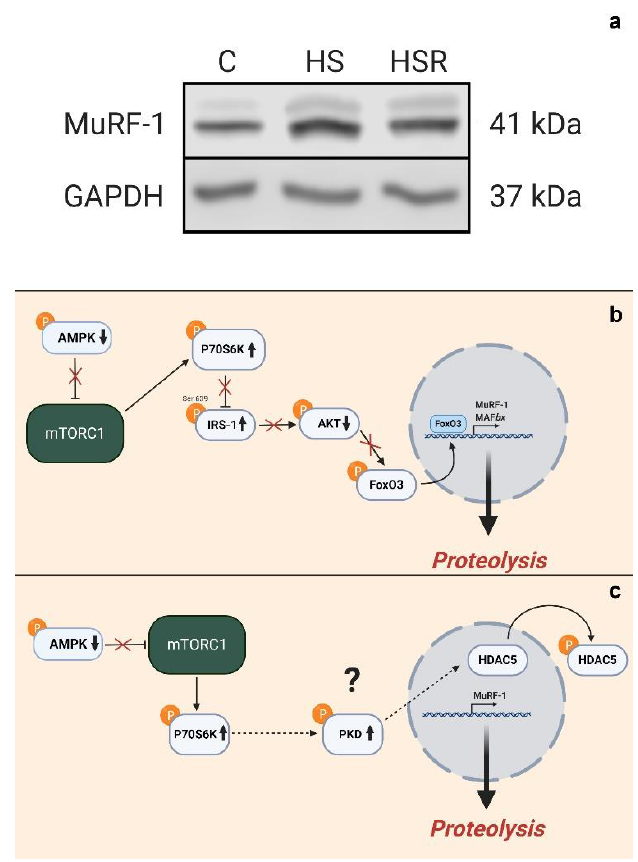
Figure 3. Causes and signaling consequences of the increased phosphorylation of ribosomal protein S6 kinase (p70S6K) during the first day of unloading (according to Belova et al. [13]). ( a ) Experimental confirmation of the role of increased p70S6K (Thr389) phosphorylation in the early increase in the expression of E3-ubiquitin ligases. During the first day of unloading, there is an increase in protein expression levels of MuRF-1. When rapamycin (mTORC1 inhibitor) reduces the level of p70S6K phosphorylation, the increase in MuRF-1 expression is not detected. ( b ) An initial hypothesis suggesting the role of increased p70S6K phosphorylation in the regulation of MuRF-1 expression via IRS-1 downregulation (Hsieh et al. [55]). AMPK dephosphorylation leads to the mTORC1 unblocking and increased p70S6K phosphorylation, which, in turn, phosphorylates IRS-1 at Ser639 thereby inhibiting downstream components of IGF-1- signaling. These events can lead to FOXO3 nuclear and increased MuRF-1expression. However, it turned out that the blocking of this signaling cascade does not depend on p70S6K phosphorylation. ( c ) A working hypothesis suggesting the role of increased p70S6K phosphorylation in stimulating MuRF-1 expression through the removal of the histone deacetylase 5 (HDAC5)-related epigenomic blockade. As shown in the experiment with rapamycin treatment during 24-h hindlimb unloading, the increased p70S6K phosphorylation leads to the HDAC5 nuclear export and resulting in the release of murf1 gene and increased expression of the E3-ubiquitin ligase MuRF-1. Protein kinase D may be involved in this process (Vilchinskaya et al. [16]).